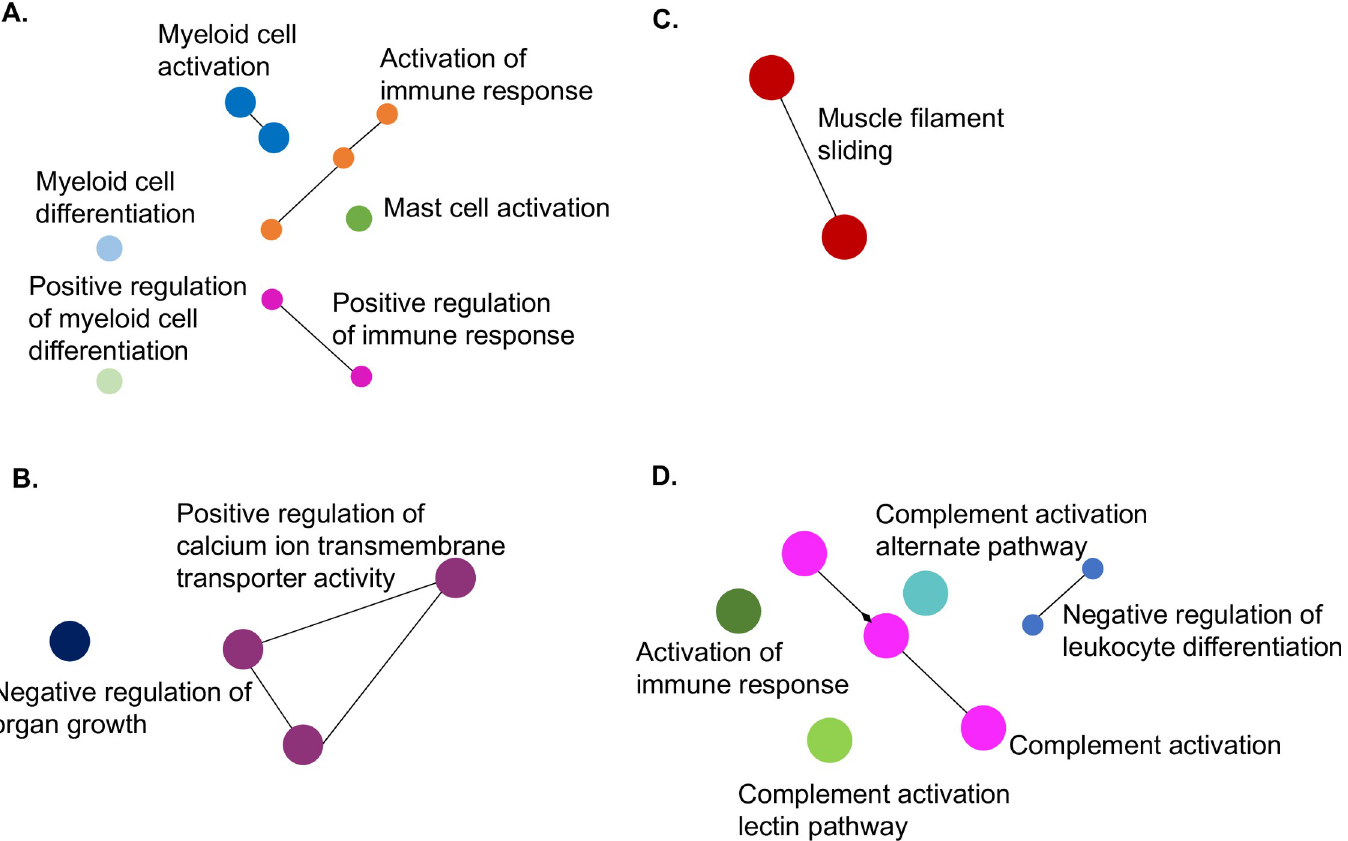
Fig 6. GO analysis of proteomics data showing downregulated pathways in bat and ferret lung. Downregulated pathways following HeV infection (60 hpe) compared to uninfected (0 hpe). Bat lung: ( A ) BB1 and ( B ) BB2. Ferret lung: ( C ) FF1 and ( D ) FF2.